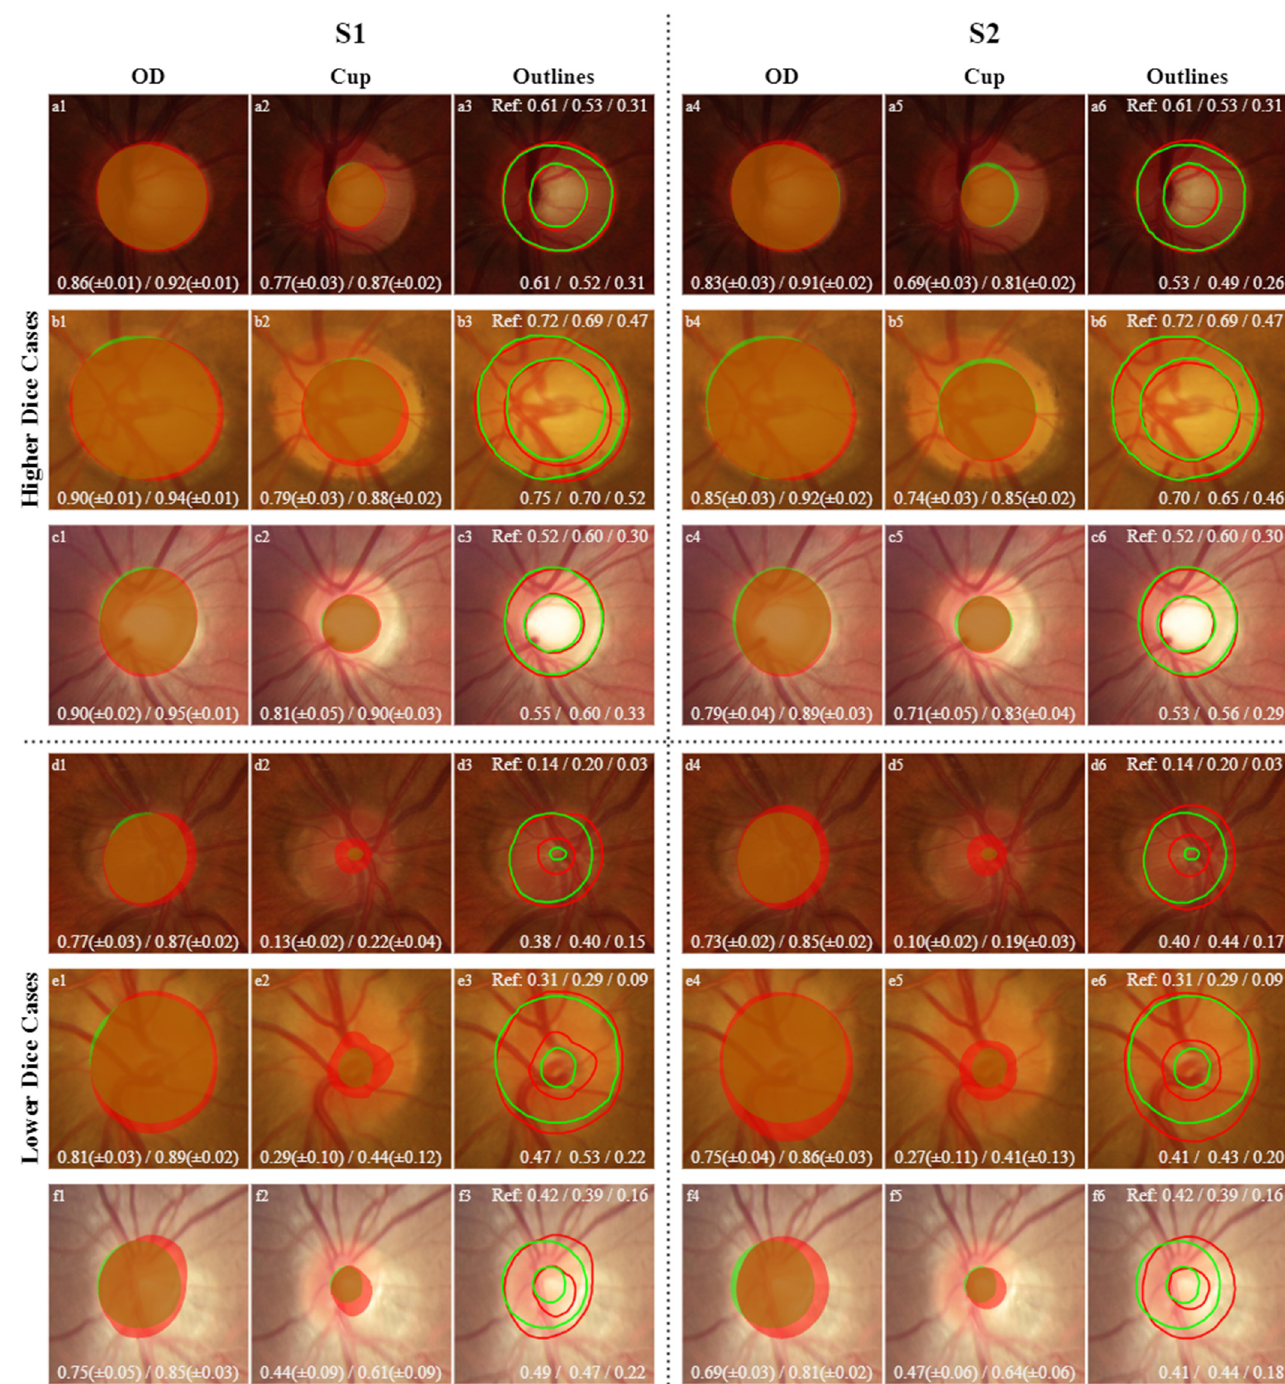
Figure 9. Higher Dice cases and lower Dice cases for each model for OD and cup segmentation with the final outlines of the OD and cup for the K-Fold CVDB. Green represents the masks and outlines of the Ref, and red represents the masks and outlines of the predictions from the models. The lower right corner shows the mean IoU/Dice for OD and cup segmentation for every fold in each model with the respective standard deviation; the “Outlines” columns at the top are the Ref values of the CDRs (VCDR/HCDR/ACDR), and the bottom of the images show the results from CDRs of the models in the same order as that described for the Ref.